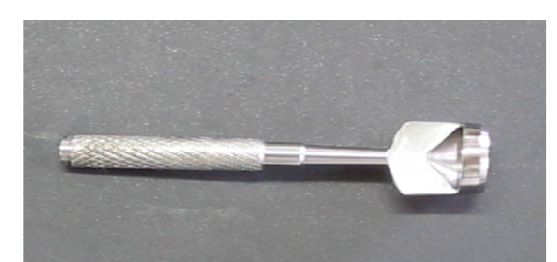
FIGURA 2 - Punch metálico para excisão cutânea. Nota: Observar a extremidade circular cortante do instrumento para demarcação da área a ser seccionada.